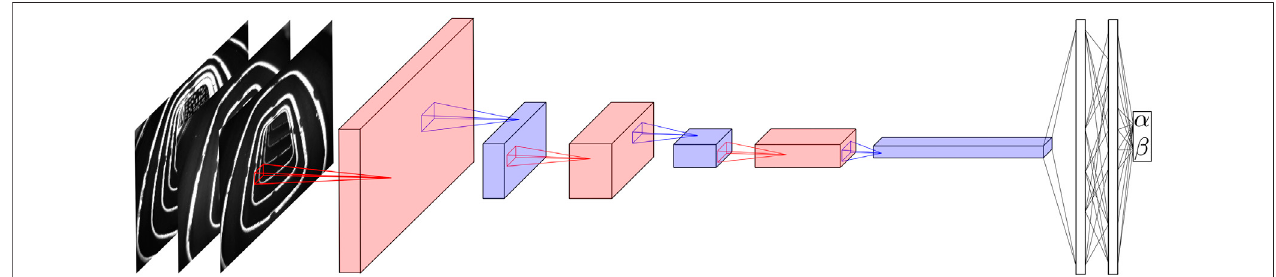
FIGURE6| The fi guredepictsthearchitectureoftheneuralnetworkemployed.Theinputconsistsofthethreecameraimagessub-sampledtoaresolutionof120 × 160pixels.Firstaconvolutionallayer(in red)isapplied, withfouroutputchannelsfollowedbyanonlinear activation(not shown)andamaxpoolingstep(inblue)reducing thesizeoftheimageto24 × 32.Theprocedureisrepeatedtwicemore,whilethenumberofchannelsisincreasedtoeightand16,respectively.Thepoolingstepsreduce the size to 6 × 8 after the second and to 3 × 4 after the third max pooling step. Finally, two fully connected layers are applied which output the angles α and β . The pooling layers reduce the number of parameters and consequently the computational complexity signi fi cantly, while retaining the most important features.